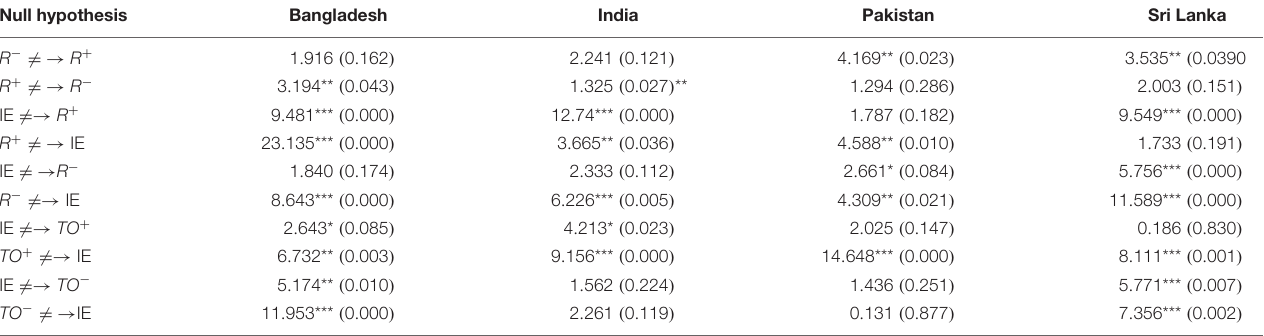
TABLE 8 | Hatemi-J asymmetric causality